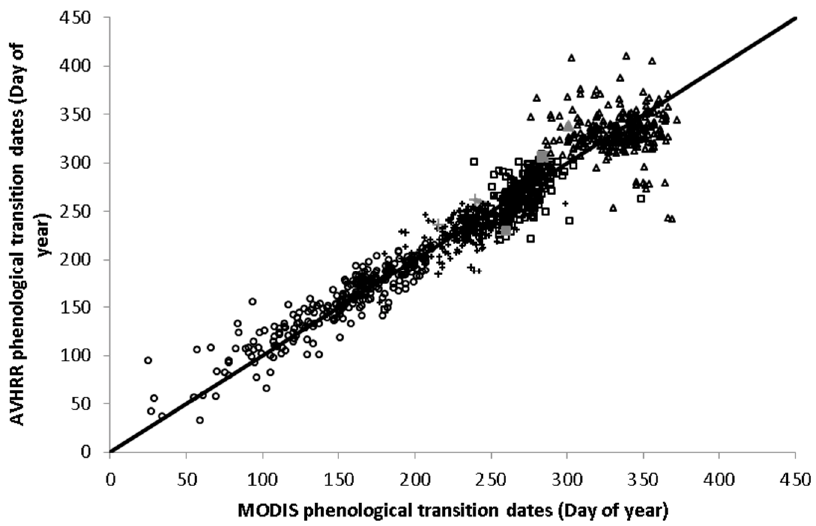
Figure 2. Scatter plot of MODIS and AVHRR phenological transition dates of 250 randomly selected points from the study area. Open circles ( ○ ) represent the dates of onset of greenness increase (RMSE = 15.5 days, r = 0.89). Crosses (+) represent the dates of onset of maturity (RMSE = 14.9 days, r = 0.71). Open squares ( □ ) represent the dates of onset of greenness decrease (RMSE = 17 days, r = 0.63). Open triangles ( Δ ) represent the dates of onset of dormancy (RMSE = 29 days, r = 0.2).